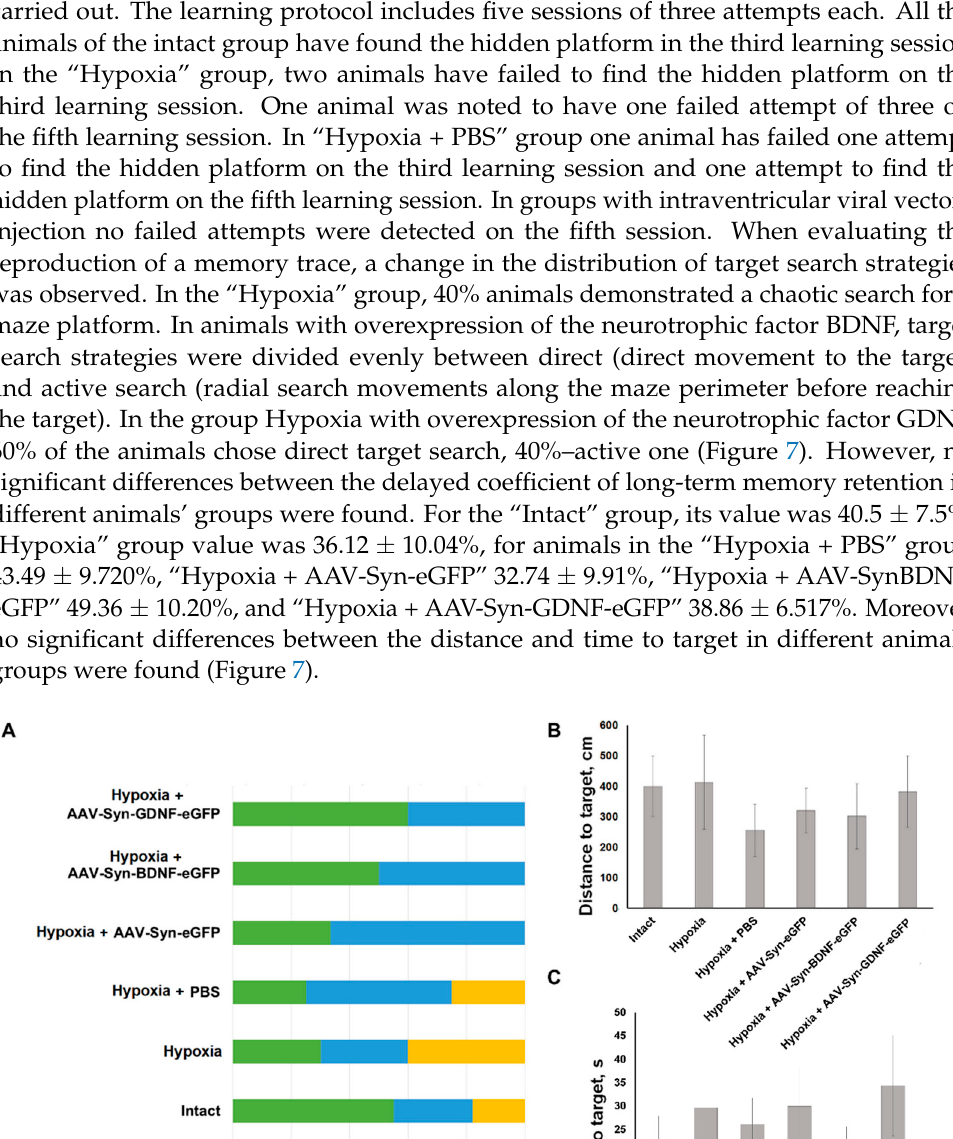
Figure 7. Distribution of target search strategies, time and distance to target of animals tested in the Morris water maze, %. No significant differences between the different groups were found, p < 0.05, the Kruskal–Wallis test. p < 0.05, the Kruskal–Wallis